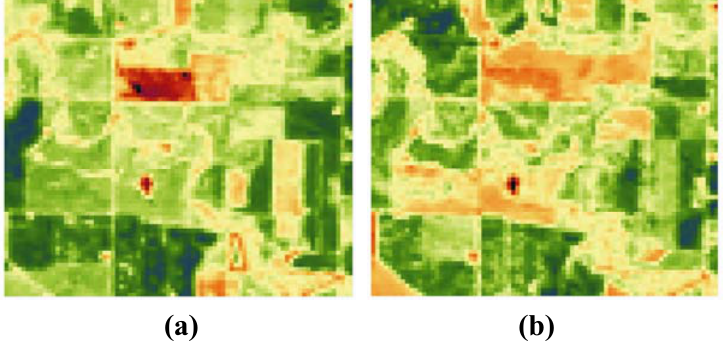
Figure 5. Greenness index characterization time sequence continued: (a) 23 August 2007, (b) 19 September